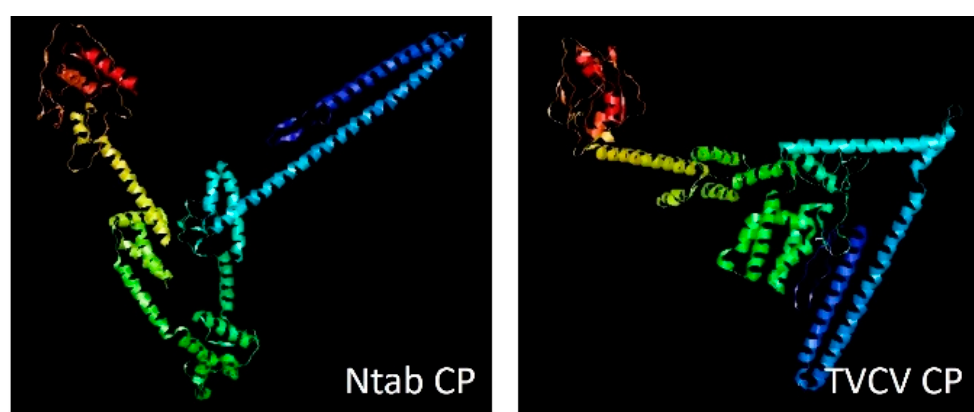
Figure 4. Predicted 3D structures of Ntab-TN90_AYMY-SS16611 and TVCV CPs. The 3D structures have been predicted by trRosetta [122] and visualized by RasMol [123] from the pdb files obtained by trRosetta [122].